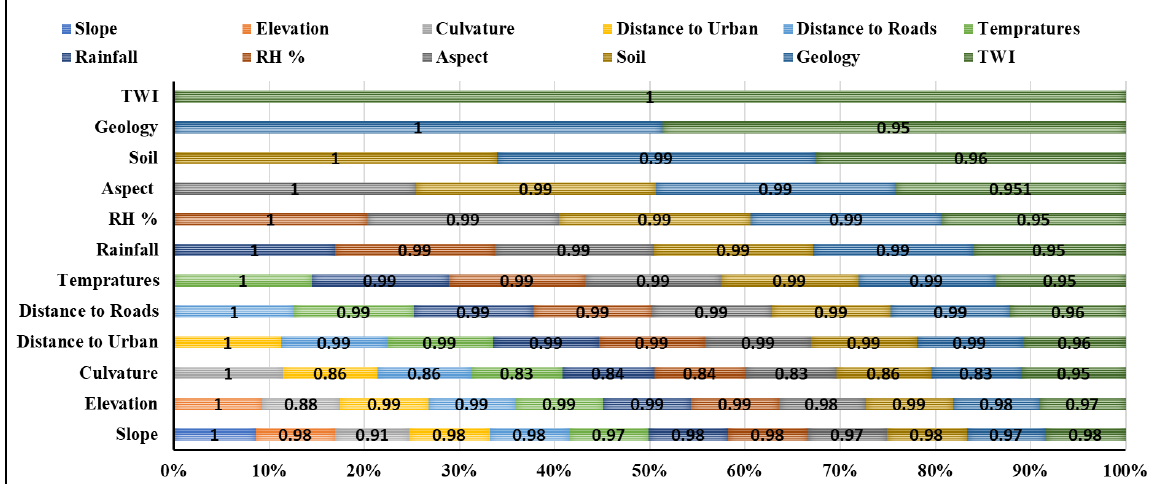
Figure 10. Predicted coefficients for various environmental parameters, including slope, elevation, rainfall, curvature, aspect, humidity, temperature, distance to roads, distance to urban areas, soil types, geology types, and topographic wetness index, which are strongly correlated with vegetation cover and health within the study area.